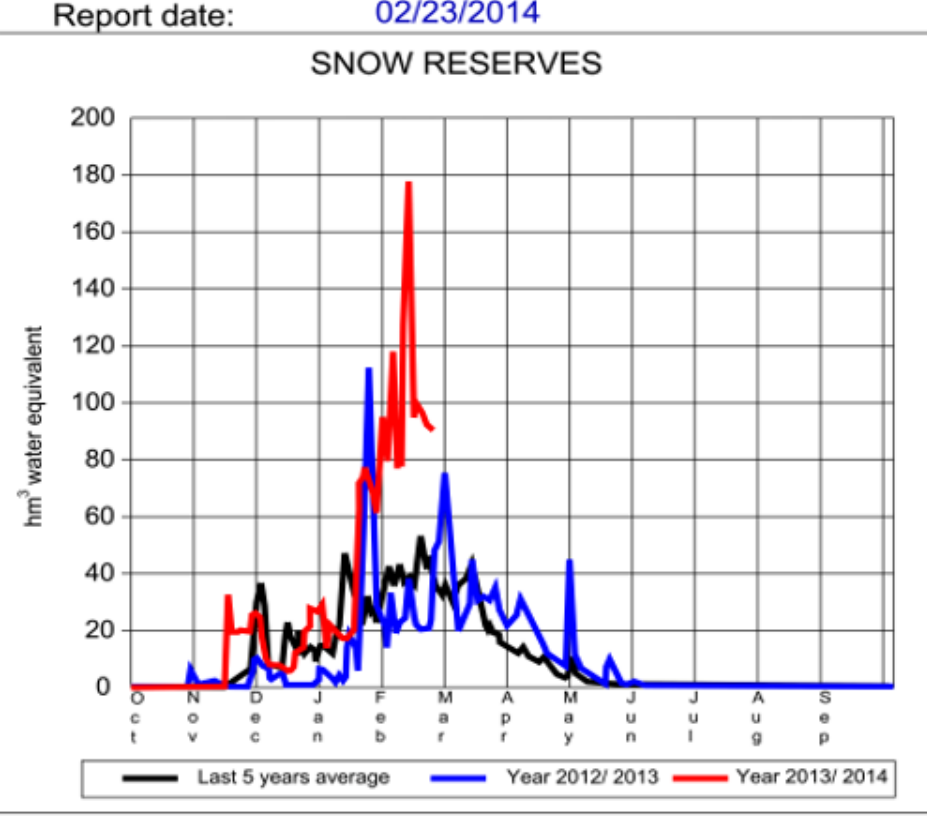
Figure 6. Graphic type of monitoring of snow reserves in the ERHIN area of the Tagus basin (Tagus Hydrographic Confederation).